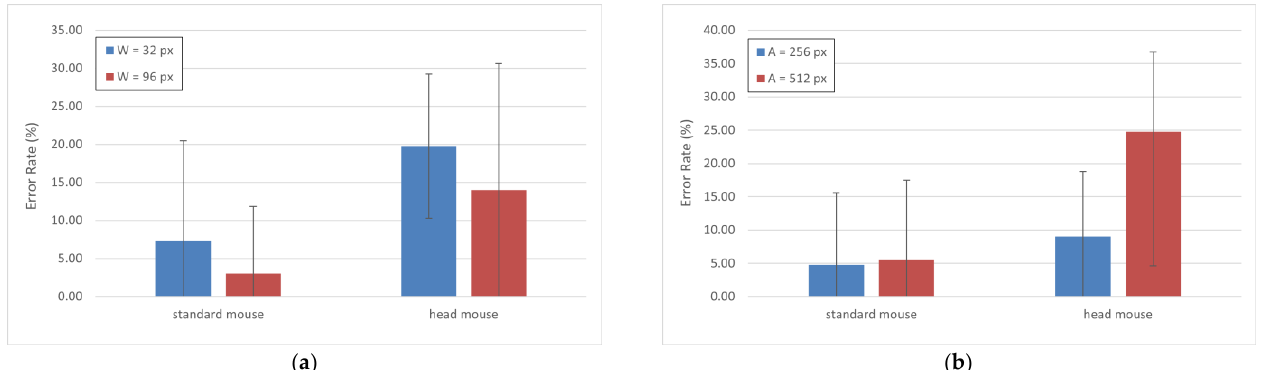
Figure 6. Error rate (%) mean values and standard deviations. Statistically significant changes for the head mouse ( p < 0.1 [ · ]) (not normally distributed samples, parametric test: Wilcoxon signed rank test with continuity correction with paired samples).